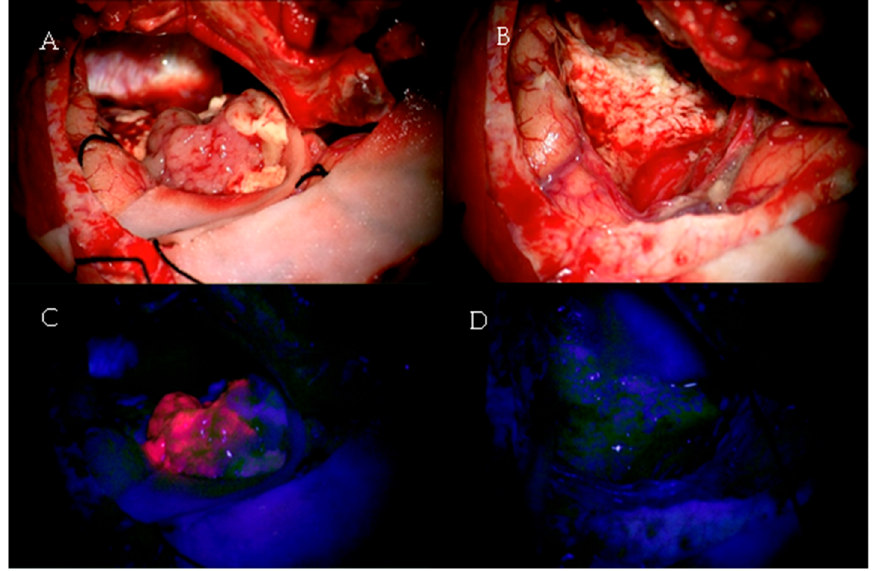
Figure 1. A 61-year-old patient with a left temporal glioblastoma. The upper row shows the operative field in white light prior to ( A ) and after ( B ) tumor resection. The lower row shows the corresponding fluorescence images ( C , D